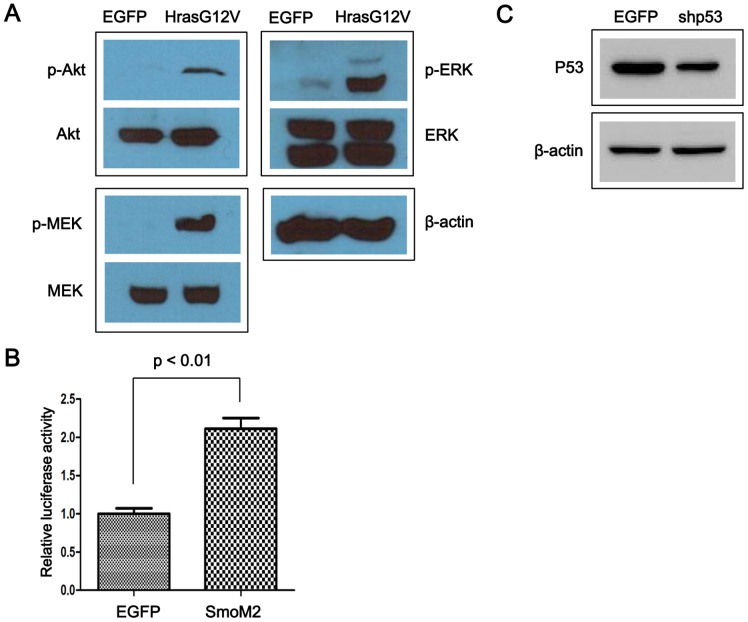
Assessment of the biological functions of HrasG12V, SmoM2, and shp53.(A) Activation of Ras signaling by HrasG12V was confirmed by increased phosphorylation of Akt, ERK, and MEK. (B) Increased activity of Gli transcription factors in response to expression of SmoM2 was detected using a Gli-driven luciferase reporter system. (C) UV-induced expression of p53 was suppressed by shp53 expression. Cells were transfected with either pT2/EGFP (a control) or pT2/shp53 prior to UV irradiation.